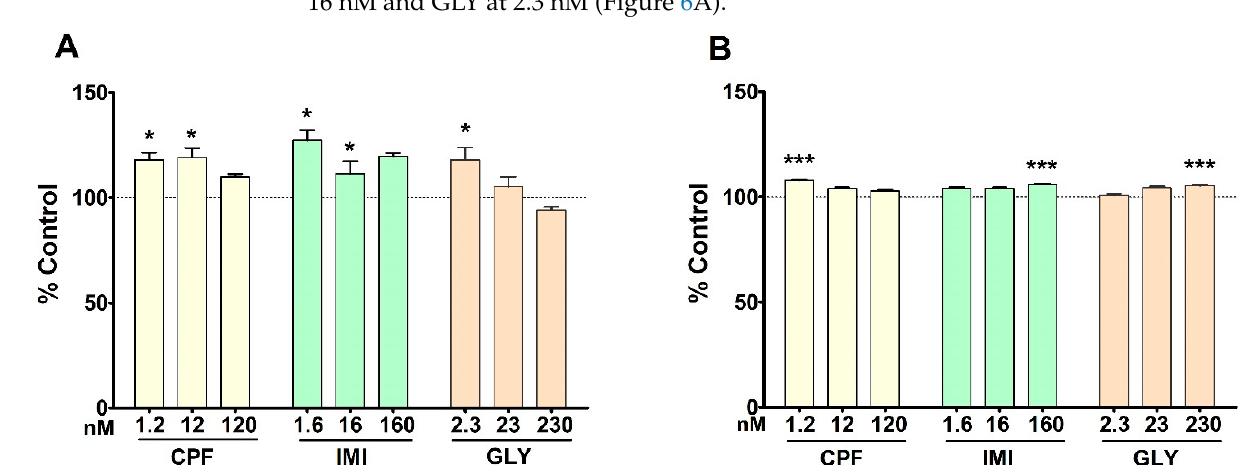
Figure 6 . E2 secretion in MCF-7 cells ( A ) and MCF-12A cells ( B ) following treatment with CPF, IMI and GLY or medium alone as a control, for 72 h. Values are means ± SEM of three independent experiments with control cells set at 100%. Asterisks indicate statistically significant differences with respect to control cells: * p < 0.05; *** p < 0.001.